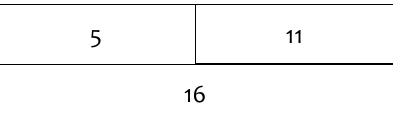
Figure 5: Sam’s solution to 5 and 11 part-part